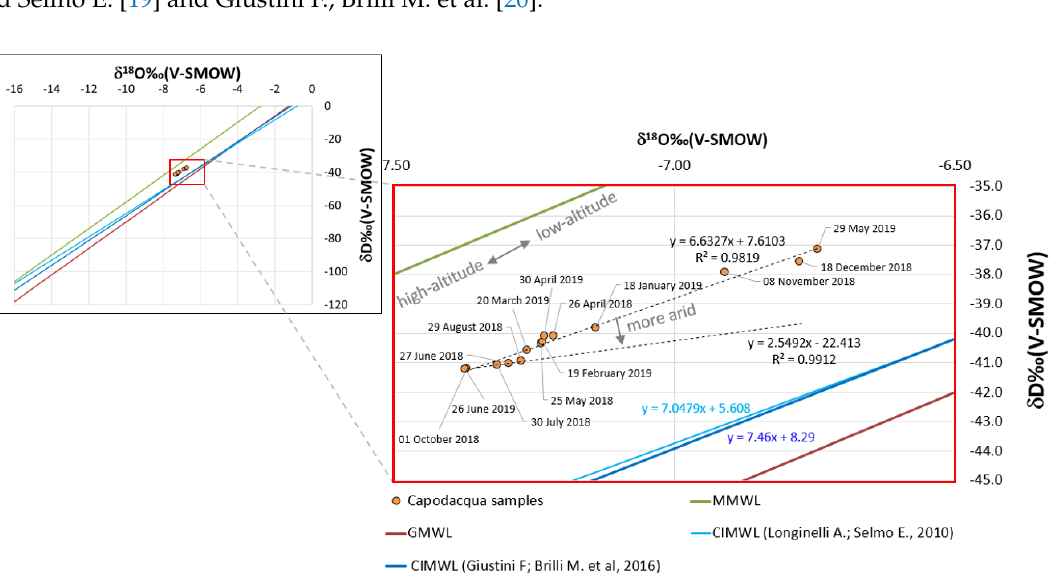
Figure 4. Plot of δ 2 H vs. δ 18 O for Capodacqua di Spigno samples.